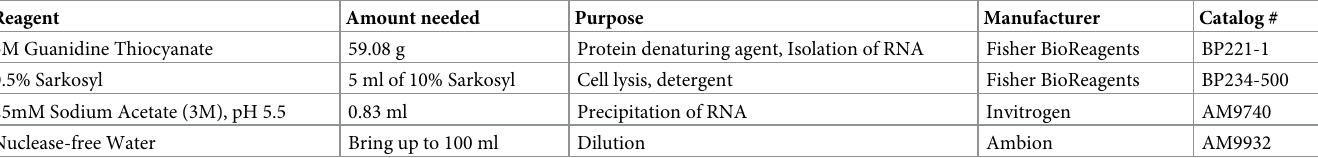
Table 1. DRUL buffer